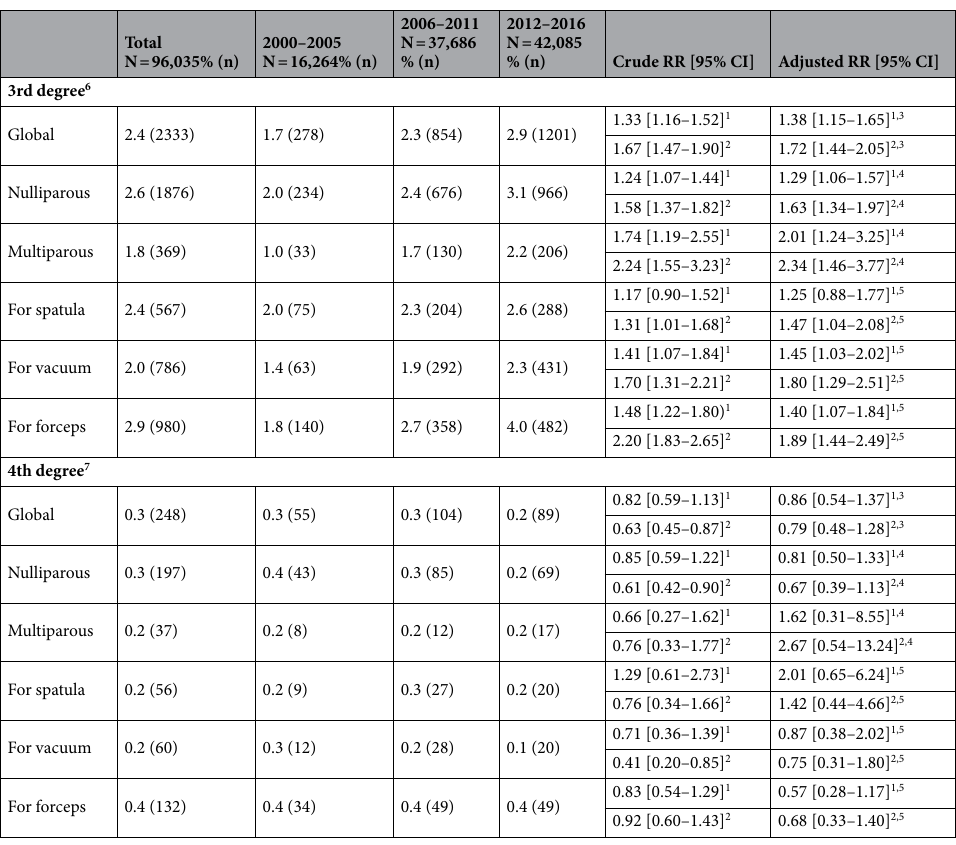
Table 4. Third- and fourth-degree perineal tears rates in the overall cohort and according to the 3 studied periods. 1 RR: 2006–11 vs. 2000–2005. 2 RR: 2012–16 vs. 2000–2005. 3 RR 2006–11 vs. 2000–2005 adjusted for: geographical origin (France or Southern Europe or North Africa or other origin vs. Asia vs. Africa), BMI (< 25 vs. ≥ 25), parity (nulliparous vs multiparous), instrumental delivery type (vacuum vs. forceps, vs. spatulas), episiotomy (yes, no), percentile birthweight (≤ 90 vs. > 90), head circumference (< 36 cm vs. ≥ 36 cm) and level of maternity ward (I vs. II, vs. III). 4 RR 2006–11 vs. 2000–2005 adjusted for: adjusted for: geographical origin (France or Southern Europe or North Africa or other origin vs. Asia vs. Africa), BMI (< 25 vs. ≥ 25), instrumental delivery type (vacuum vs. forceps, vs. spatulas), episiotomy (yes, no), percentile birthweight (≤ 90 vs. > 90), head circumference (< 36 cm vs. ≥ 36 cm) and level of maternity ward (I vs. II, vs. III). 5 RR 2006–11 vs. 2000–2005 adjusted for: geographical origin (France or Southern Europe or North Africa or other origin vs. Asia vs. Africa), BMI (< 25 vs. ≥ 25), parity (nulliparous vs multiparous), episiotomy (yes, no), percentile birthweight (≤ 90 vs. > 90), head circumference (< 36 cm vs. ≥ 36 cm) and level of maternity ward (I vs. II, vs. III). 6 Third-degree tears involve the anal sphincter, with either total or partial damage to the sphincter. 7 Fourth-degree tears involve the anal sphincter and tears into the rectal